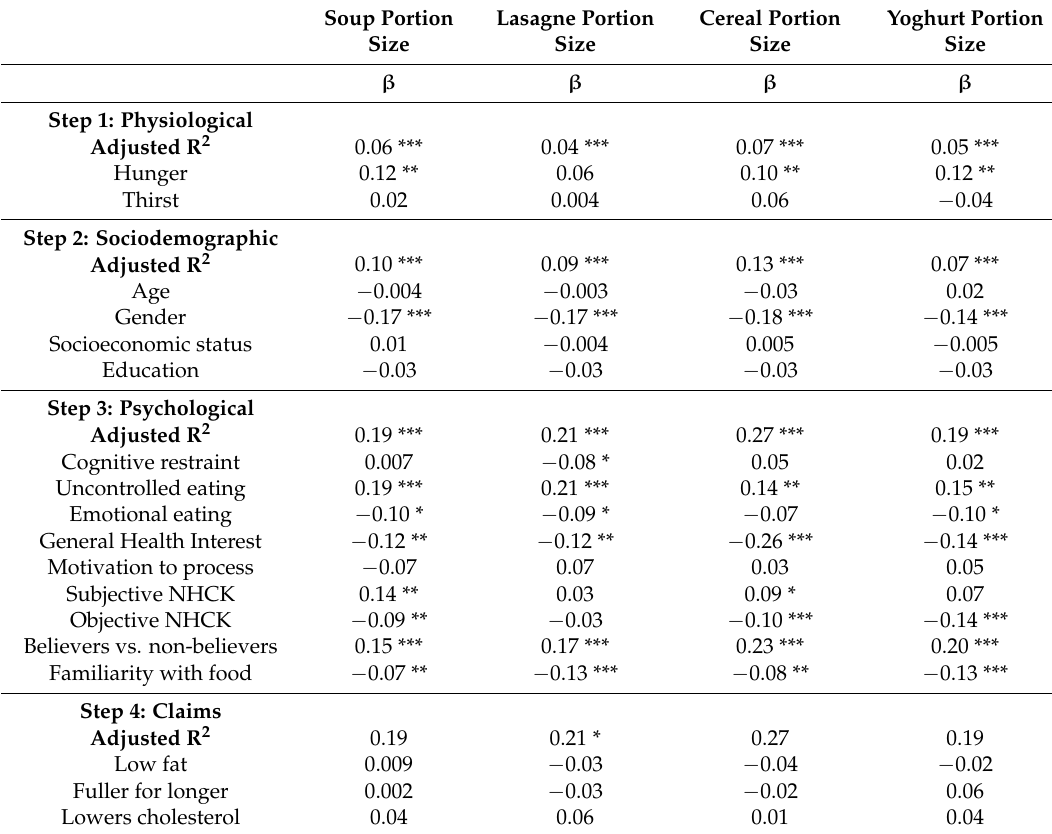
Table 3. Explained adjusted variance and standardized coefficients ( β ) for each regression for portion size selection after the addition of each